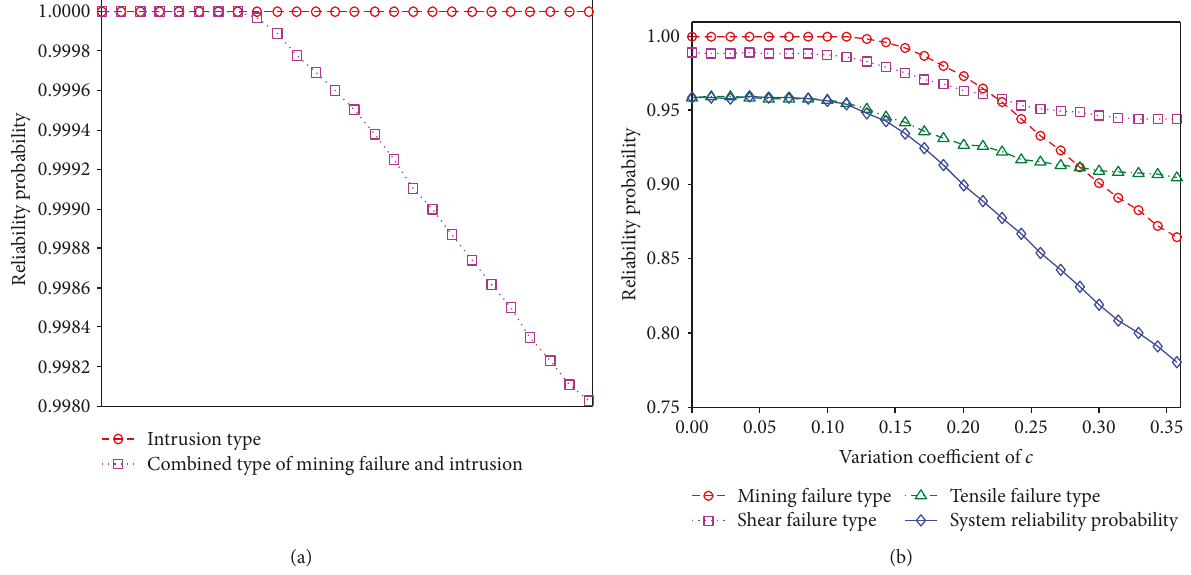
Figure 7: Relationship between variation coe ffi cient of random variables c and reliability probability. (a) Failure modes of intrusion type and the combined type of mining failure and intrusion and (b) mode of mining failure, shear and tensile failure in key strata, and system failure.